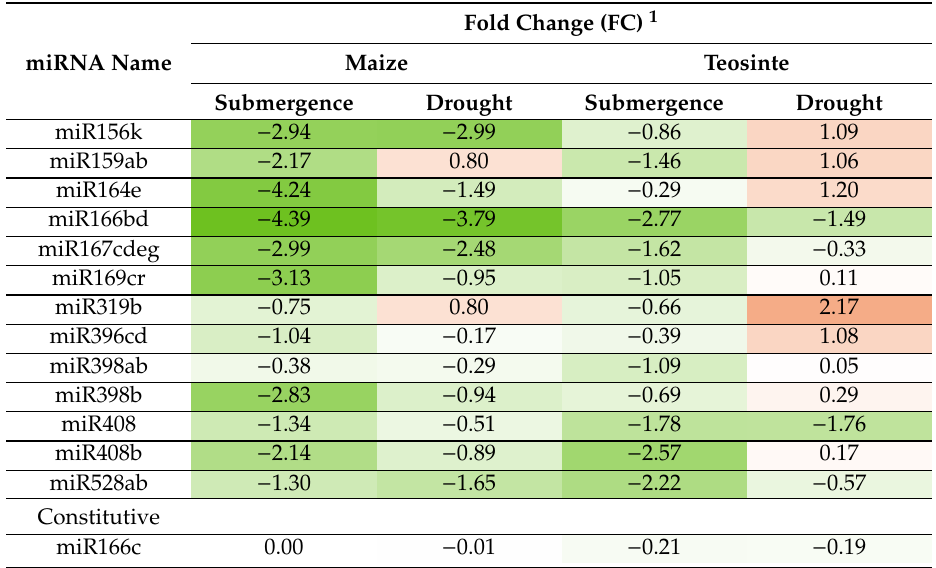
Table 2. Representative plant miRNAs responsive to submergence and drought in maize and teosinte.